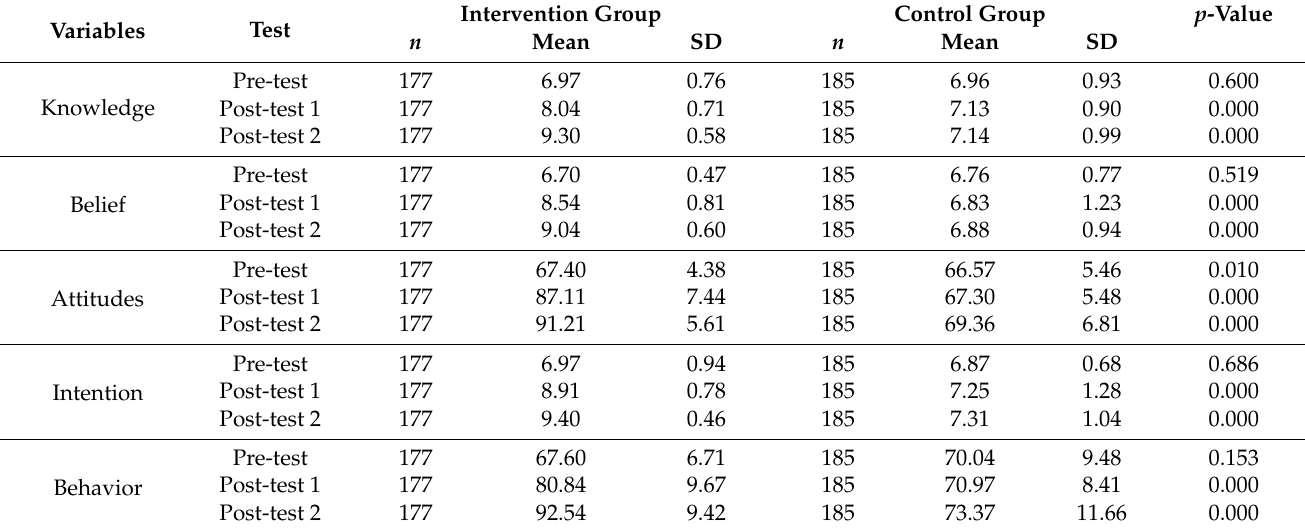
Table 2. Results of bivariate analysis between respondents based on